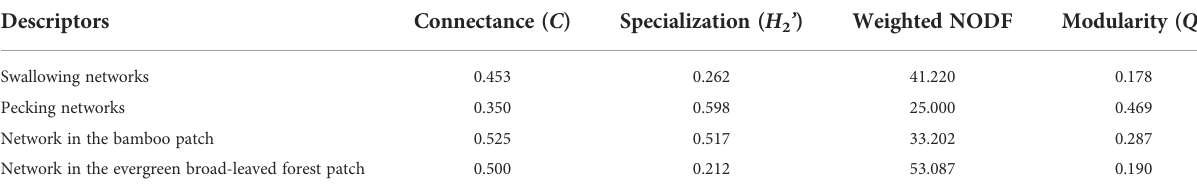
TABLE 1 Comparison of network metrics among four seed dispersal networks based on bird foraging type (swallowing and pecking) and patch type (bamboo patch and evergreen broad-leaved forest patch) in the yew ecological garden representing a fragmented forest in Southeast